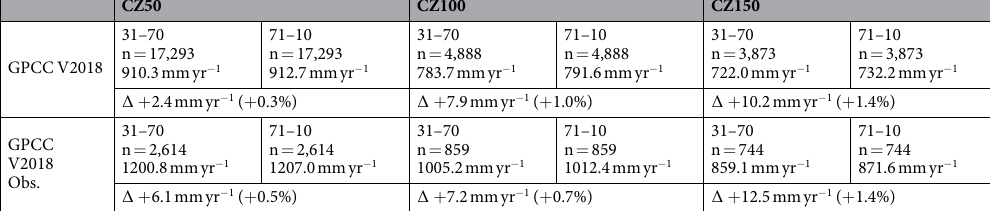
Table 2. Mean annual precipitation over two time periods: 1931–1970 and 1971–2010 for CZ50, CZ100, and CZ150 of the GPCC V2018 analysis and observation-only products. Absolute differences between the time periods are given as well as the percent differences.